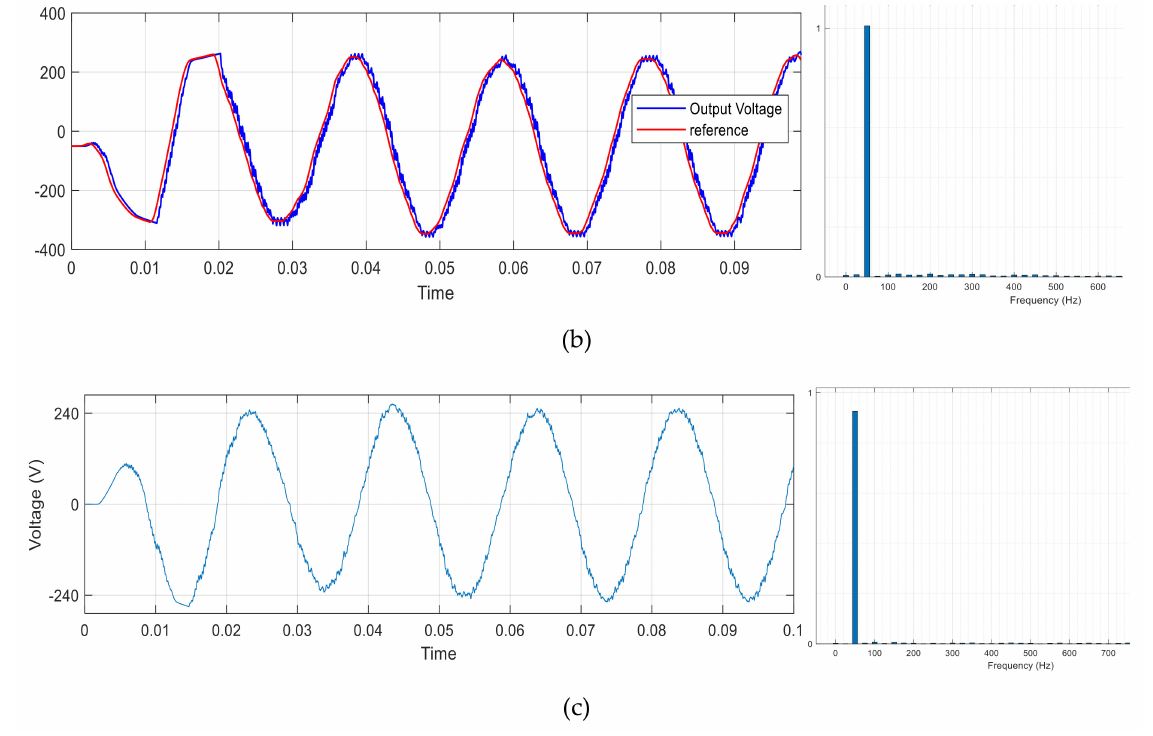
Figure 19. Frequency spectrum, ( a ) inverter output current, ( b ) inverter output voltage, ( c ) load